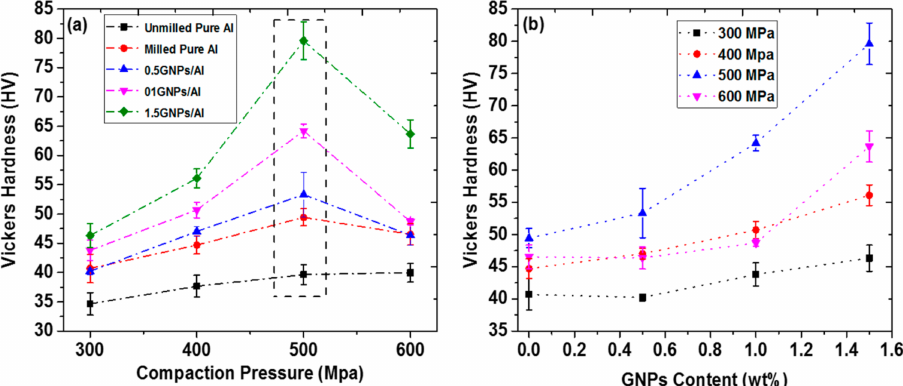
Figure 16. Effect of compaction pressure ( a ) and GNPs content ( b ) on the hardness of pure and GNPs/Al composite